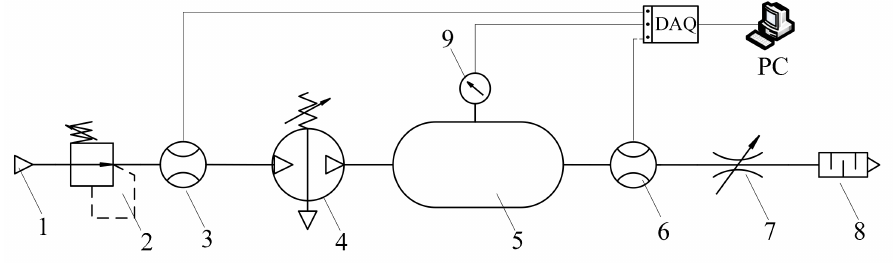
Figure 5. Schematic diagram of booster regulator test. 1: air source, 2: regulator, 3: air power metre (APM), 4: booster regulator, 5: air tank, 6: APM, 7: throttle valve, 8: silencer, 9: pressure sensor.